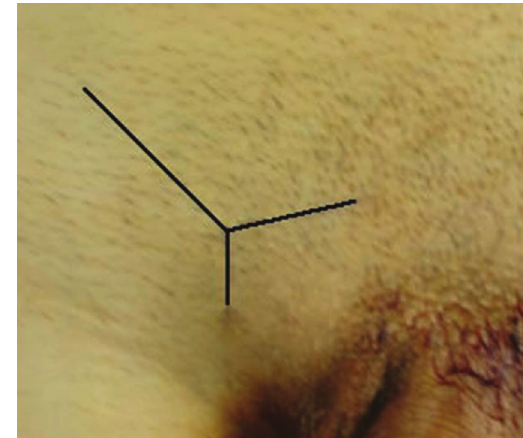
Figure 2 - Incision location